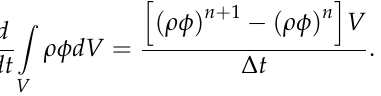
Figure 5. The mesh of waterjet system.